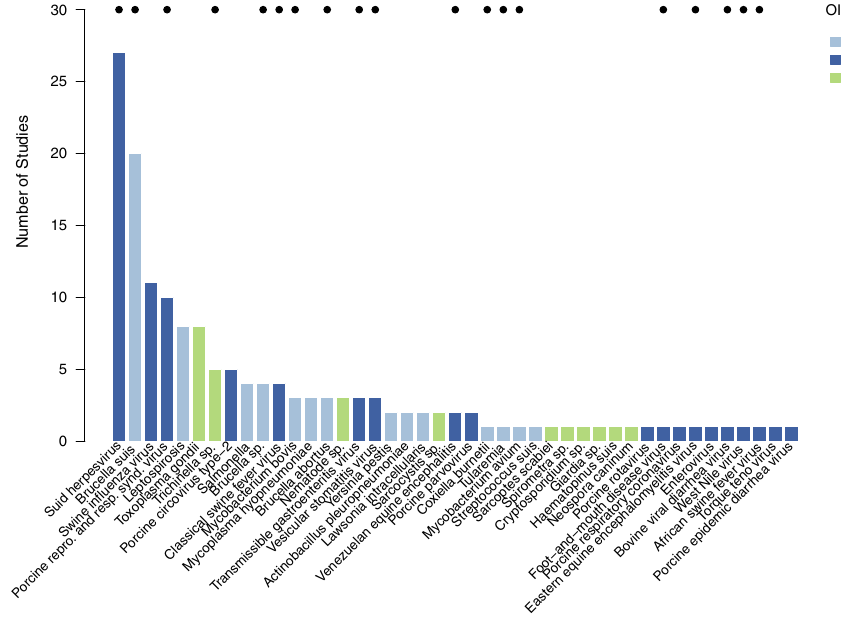
Figure 2. Number of scientific peer reviewed publications (n = 72) reporting results of prevalence studies for wild pigs in North America. Dots along top margin indicate OIE listed swine pathogens (n = 19) of the total number of pathogens (n = 48) with